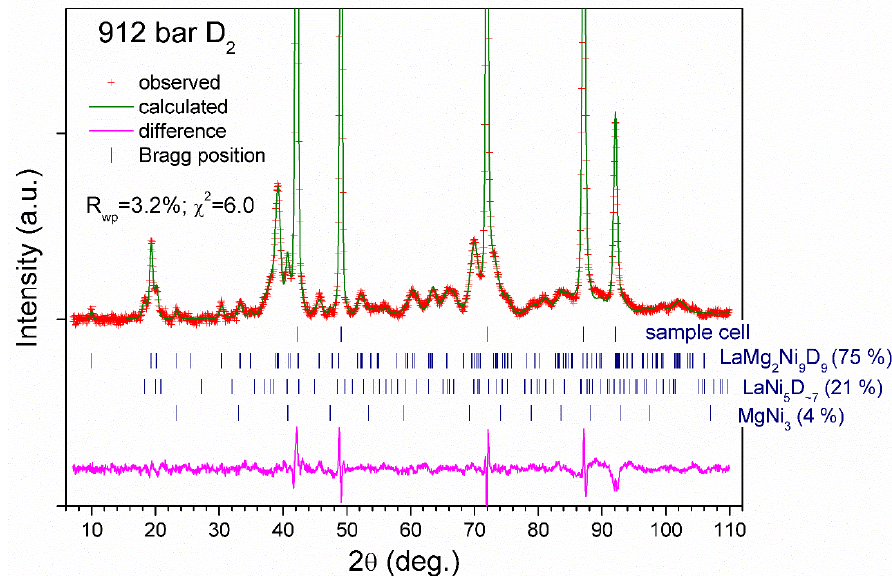
Figure 4. NPD pattern of La 0.9 Mg 2.1 Ni 9 D 9.4(6) (912 bar D 2 , 298 K). Note that the most significant contributions to the difference intensities are coming from the sample cell.